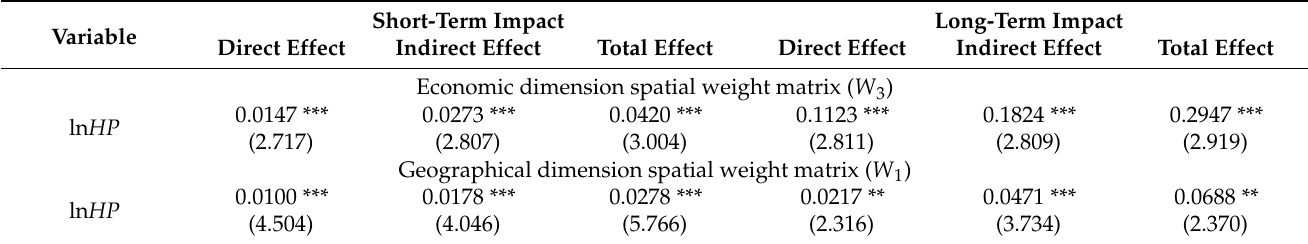
Table 5. Decomposition results of the impact of hydropower on regional economic growth.